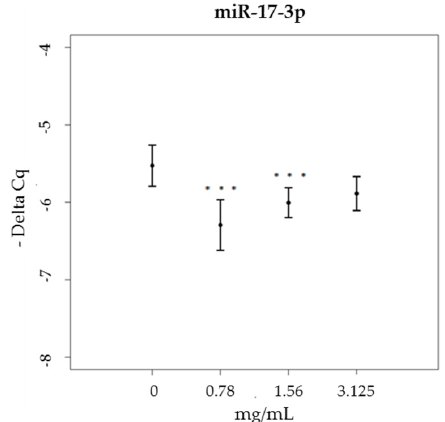
Figure 6. miR ‐ 17 ‐ 3p expression levels ( ‐ Delta Cq) in HaCat cells, treated with increasing concentrations of brown propolis extract (0.78–3.125 mg/mL).